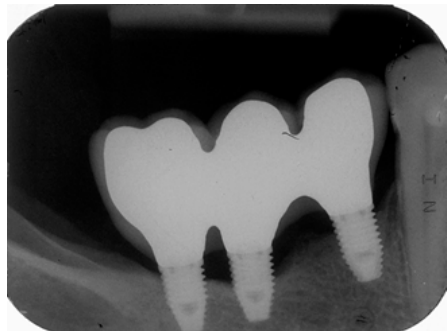
Figure 3. Periapical radiograph at 58 months of follow-up with peri-implant disease diagnosed in implant #45 with the presence of peri-implant pockets of 5 mm and a three threads marginal bone loss.